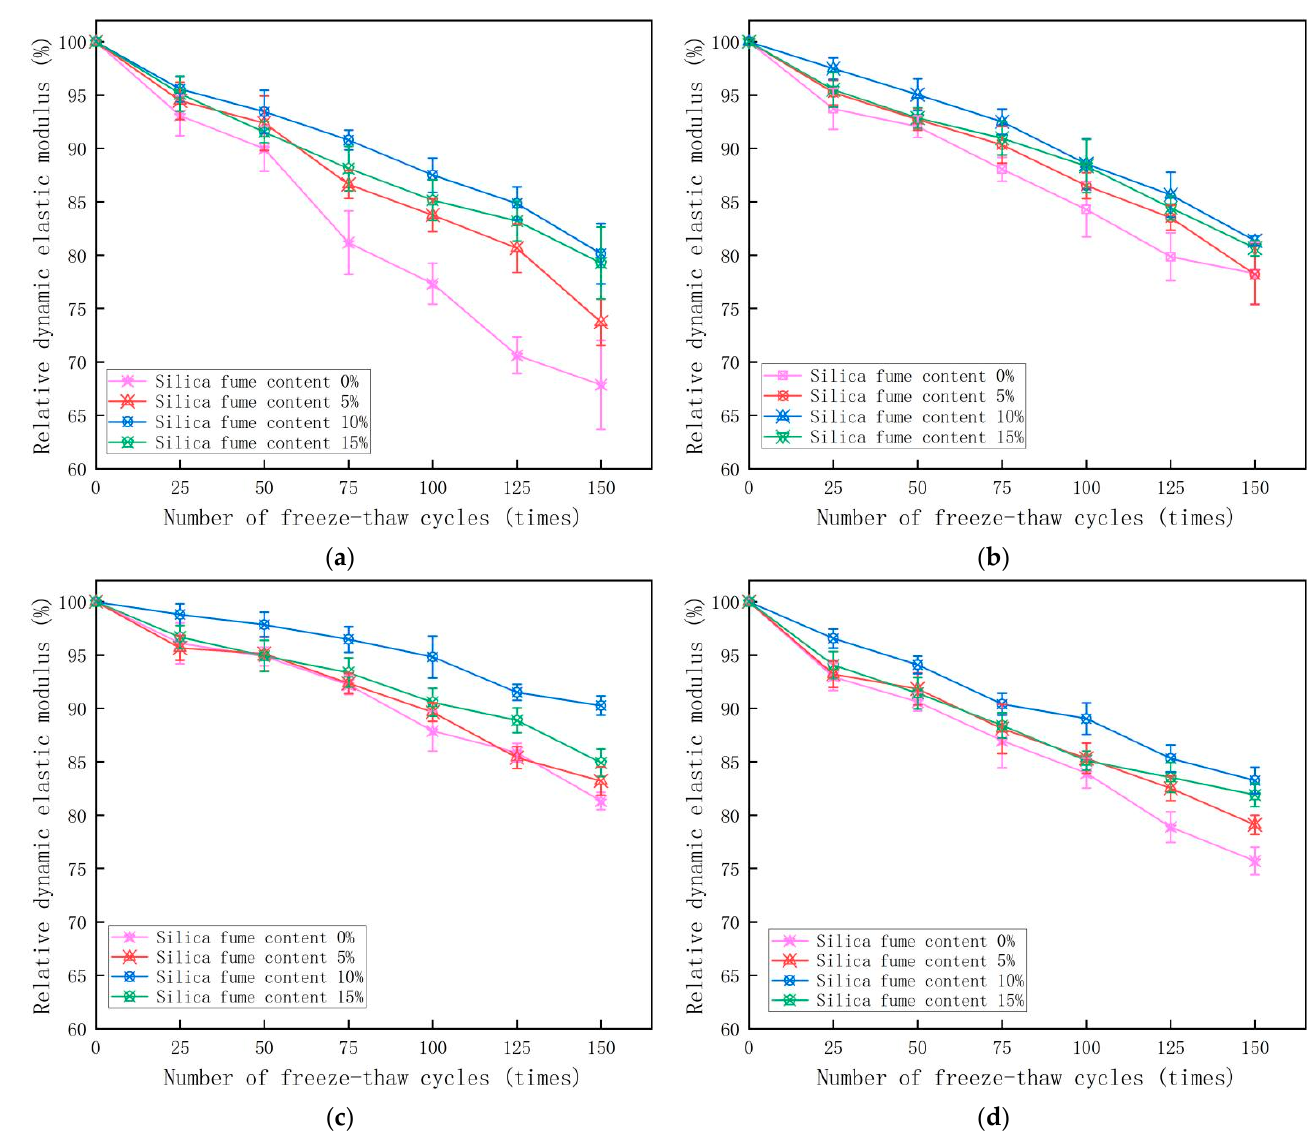
Figure 8. Relative dynamic modulus of elasticity: ( a ) Polyvinyl alcohol fiber content 0%, ( b ) Polyvinyl alcohol fiber content 0.5%, ( c ) Polyvinyl alcohol fiber content 1%, and ( d ) Polyvinyl alcohol fiber content 1.5%.